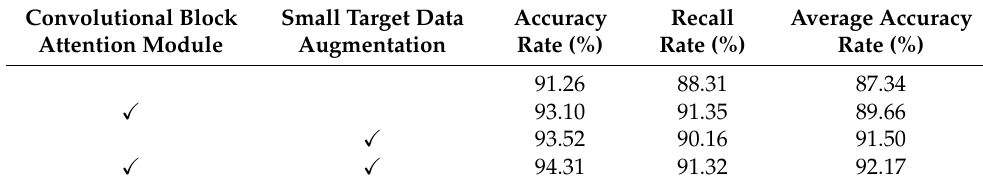
Table 3. Ablation study of detection precision of test